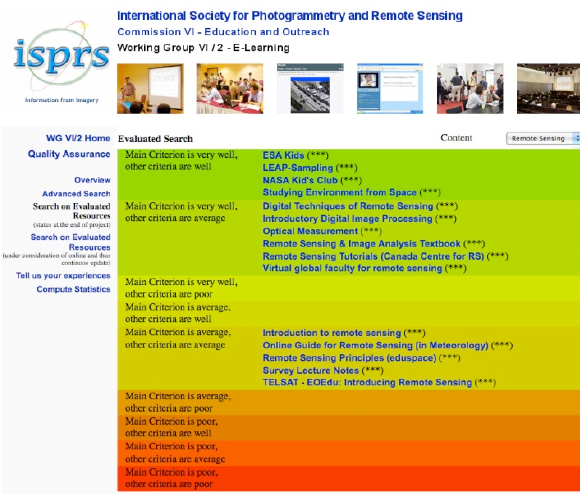
Figure 9: Review results for RS education modules